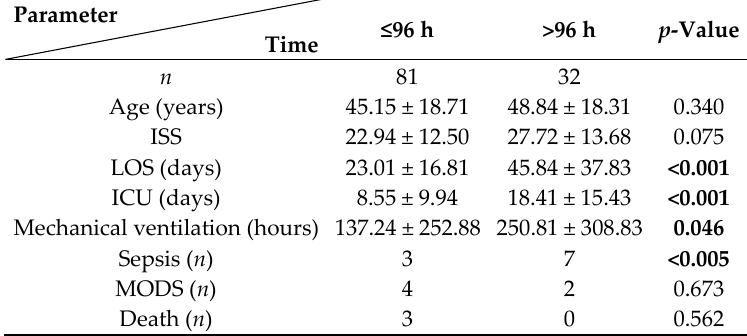
Table 5. Stratification analysis (ANOVA and chi-square test) for the time to surgery ( < 96 vs. > 96 h).